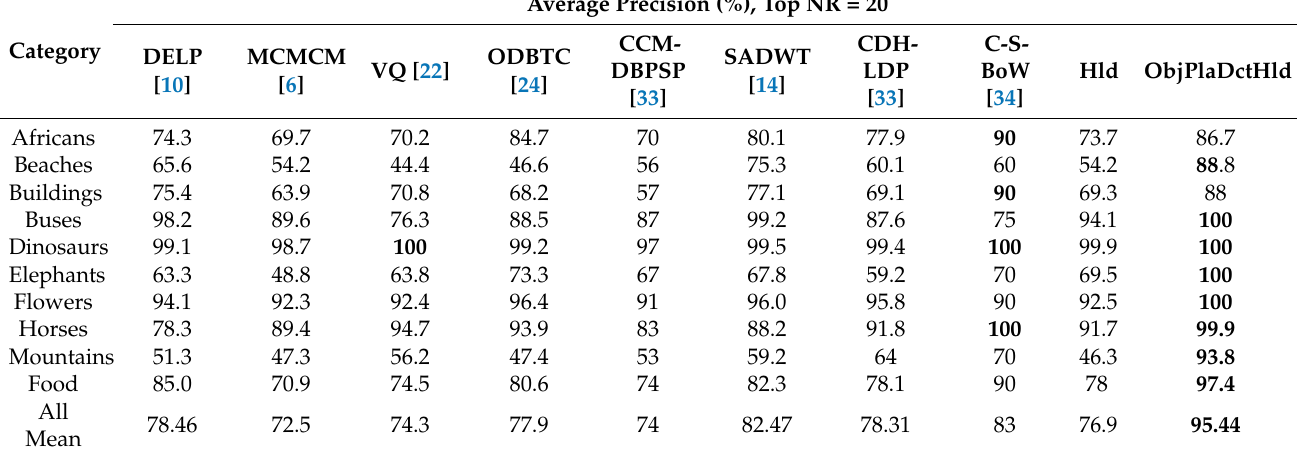
Table 1. Comparison of different image retrieval methods on the Corel-1k dataset (Top NR is 20). The bold values indicate the best results.